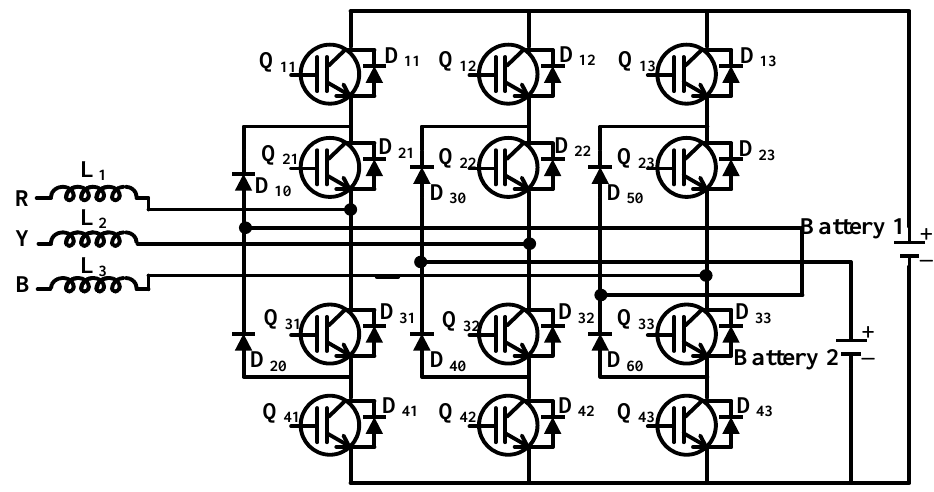
Figure 1. Topology of dual-source inverter [19].